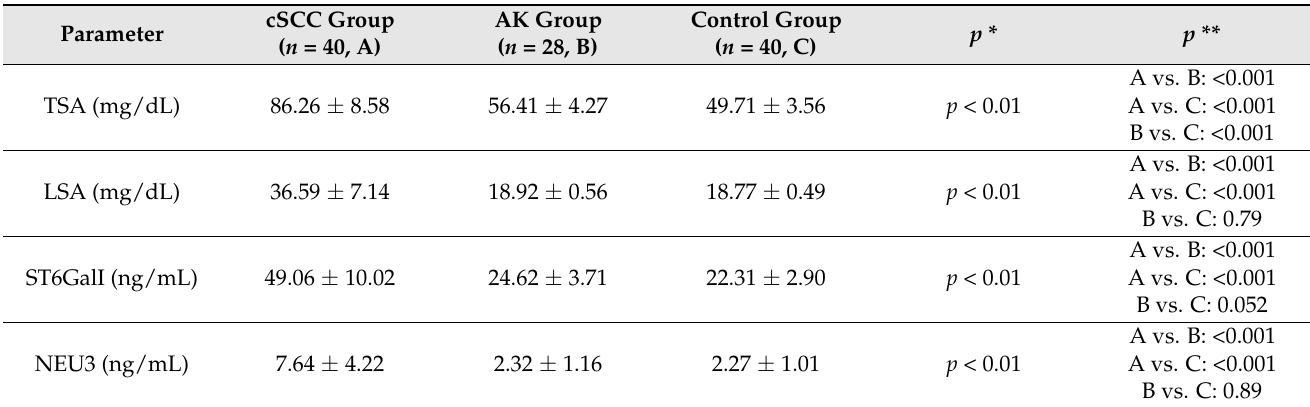
Table 2. The serum levels of TSA, LSA, ST6GalI, and NEU3 in the studied groups expressed as the mean ± standard deviation. Parameter